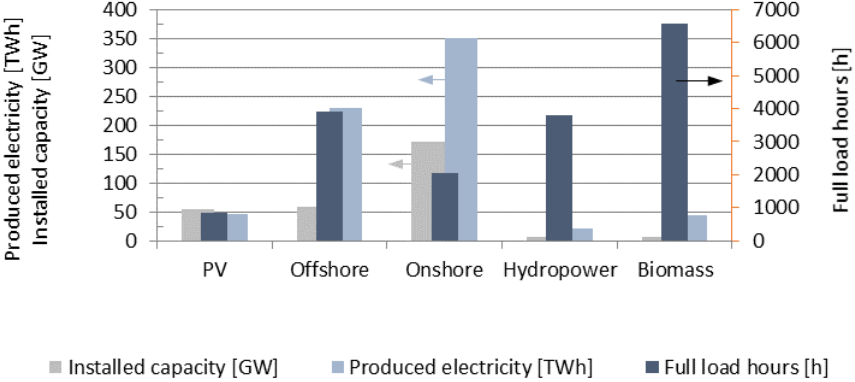
Figure 2. Example of the installed capacity, produced electricity and average full load hours by the year 2050 in Germany.